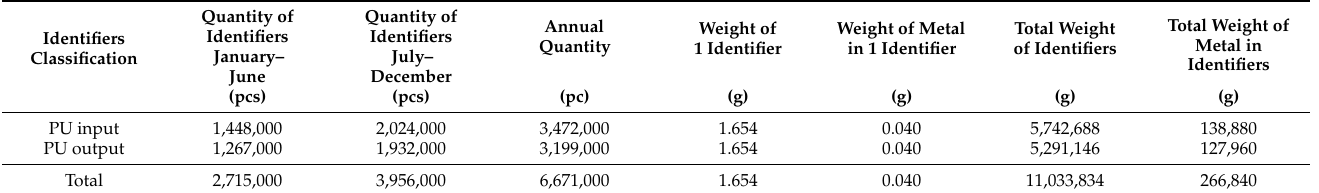
Table 3. Data for determination of the annual weight of RFID tags used in the LC by PU